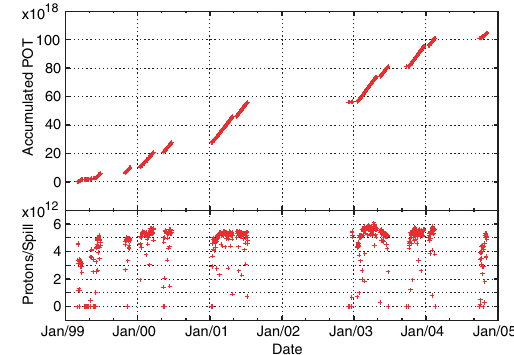
Fig. 9 The number of protons delivered to the production target in the period from June 1999 to November 2004. The horizontal axis corre- sponds to the date. The upper figure shows the total number of protons on target (POT) accumulated since June 1999, and the lower figure shows the per spill averaged in a day. In total, 104 . 90 × 10 18 protons were delivered during the entire period